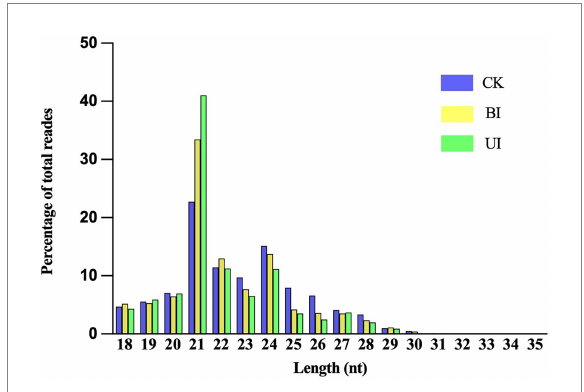
FIGURE 2 Distribution of clean reads with different sequence lengths according to their total reads in the CK (control check, without inoculation), BI (presymbiotic phase, 3 weeks after inoculation), and UI (symbiotic phase, 5 weeks after inoculation).